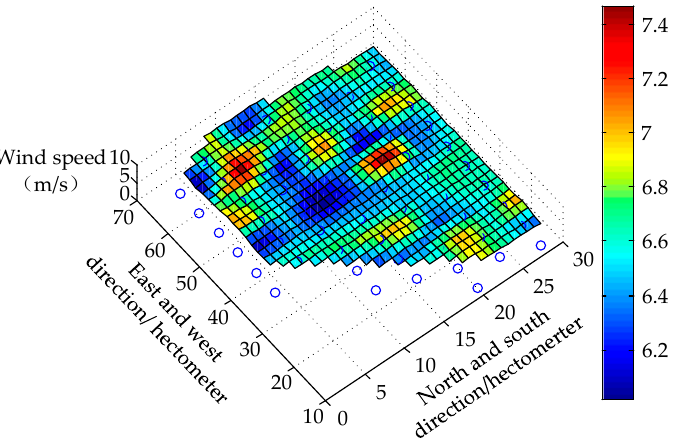
Figure 7. Monthly average wind power distribution.